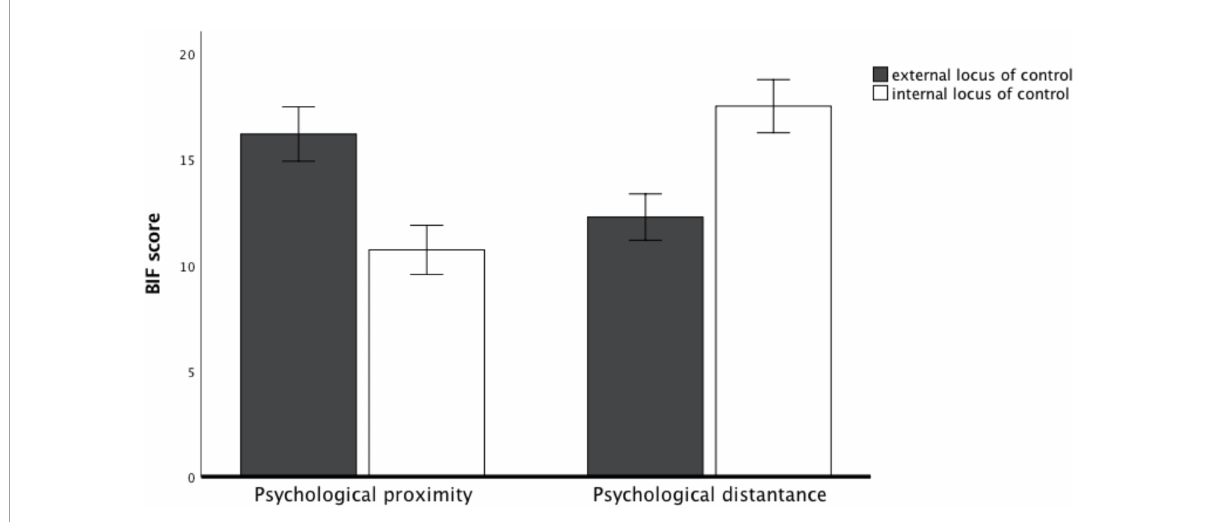
FIGURE5 BIF score as a function of the interaction of psychological distance and locus of control (study